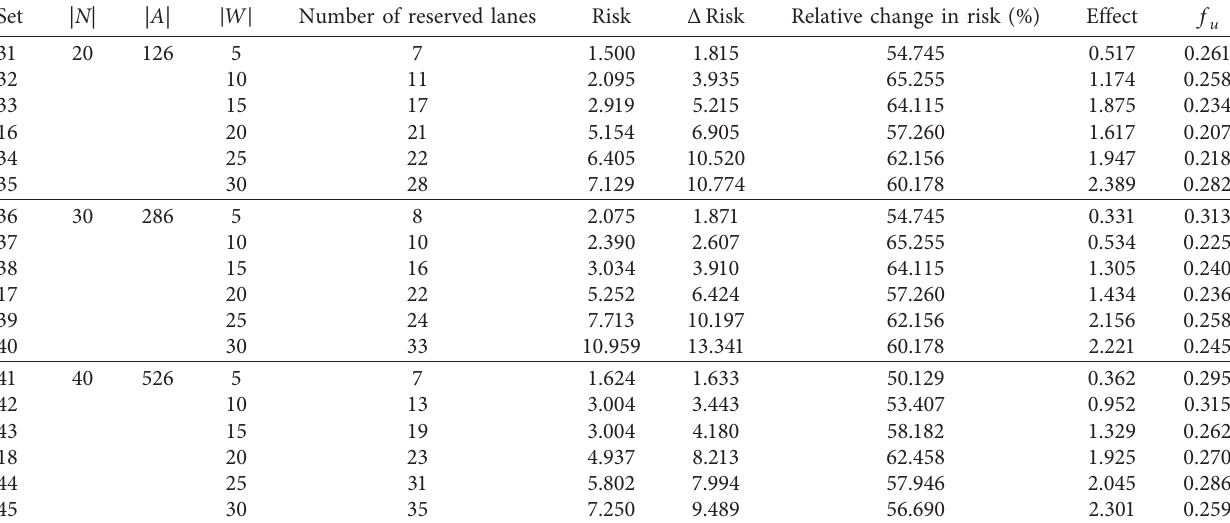
Table 8: Result of experiments with varied | W | , when α � 0.1, β � 0.1, and λ � 0.7.